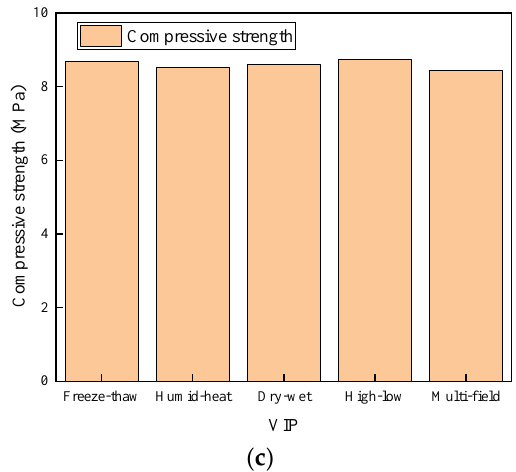
Figure 9. Changes in compressive strength of materials over the 112 days of cycling. ( a ) FC, ( b ) RPUF, and ( c ) VIP.